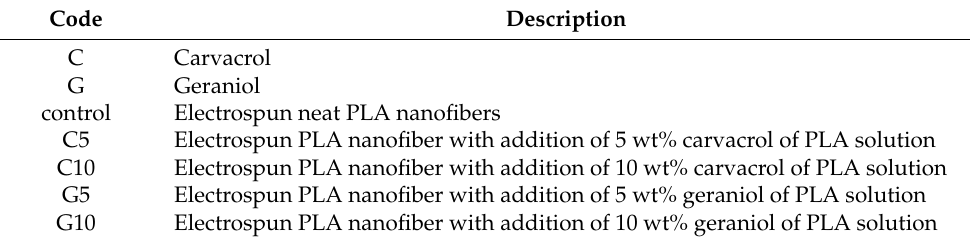
Table 1. Substrates’ sample description and Table 1. Substrates ’ sample description and characteristics.